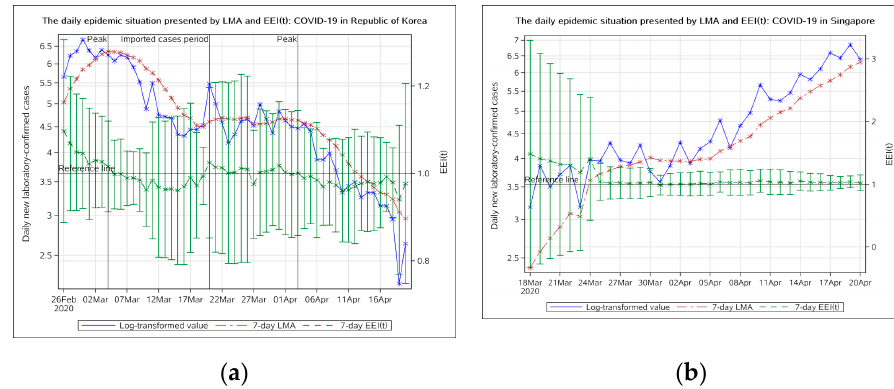
Figure 5. The daily epidemic situation presented by LMA and EEI(t), COVID-19 in the Republic of Korea ( a ) and Singapore ( b ). The blue line indicates the change of the log-transformed value over date. The brown line indicates the change of 7-day LMA over date. The green line indicates the change of the EEI(t) over date. LMA, moving average of log-transformed daily new cases and EEI(t), epidemic evaluation index (t).